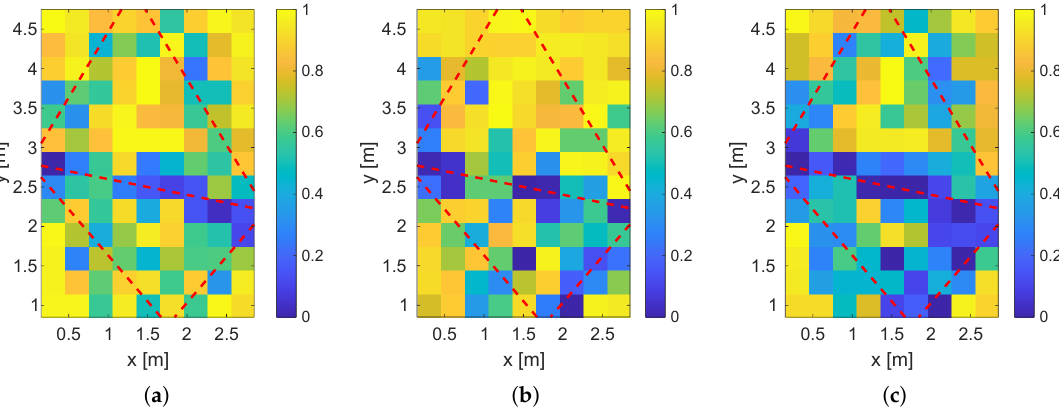
Figure 15. Fingerprinting results. ( a ) Measured relative incidence of localization errors for magnitude only. ( b ) Measured relative incidence of localization errors for phase difference only. ( c ) Measured relative incidence of localization errors for the combined magnitude and phase